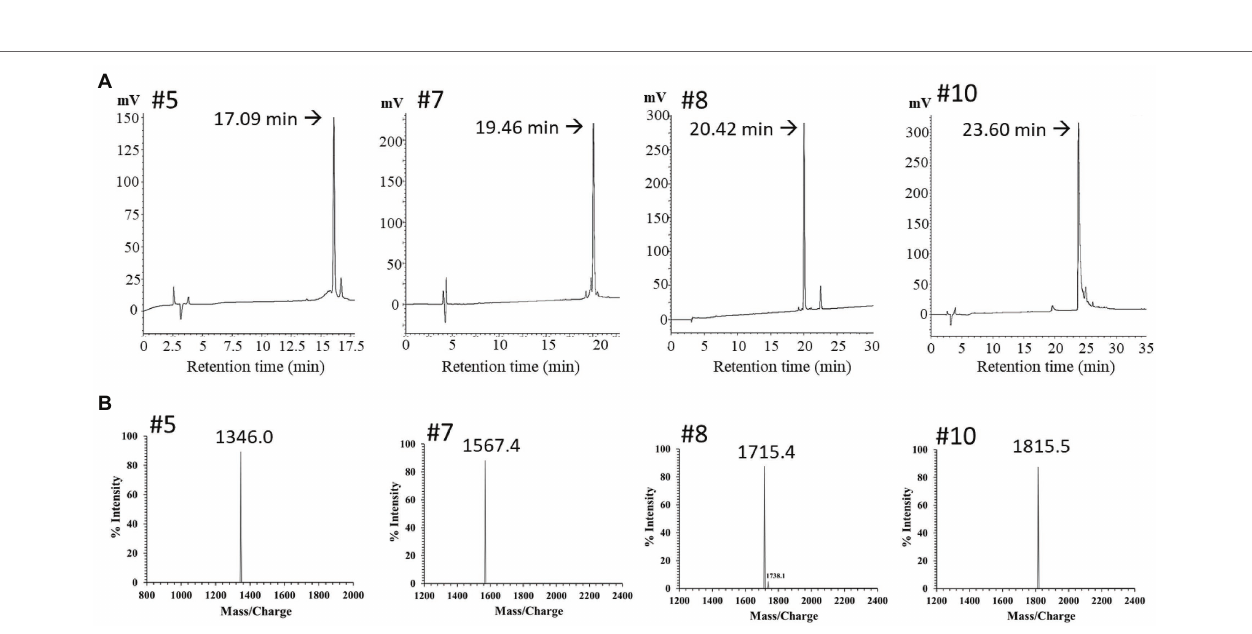
FIGURE 3 | RP-HPLC analysis of peptides from 40% (w/w) ACN fractions of pine needles and estimation of their antimicrobial activity against Staphylococcus aureus . RP-HPLC chromatograms (absorbance was monitored at 215 nm) (A) ; Peak fractions from 40% (w/w) ACN fractions of pine needles exhibiting antimicrobial activity against Staphylococcus aureus (B) .